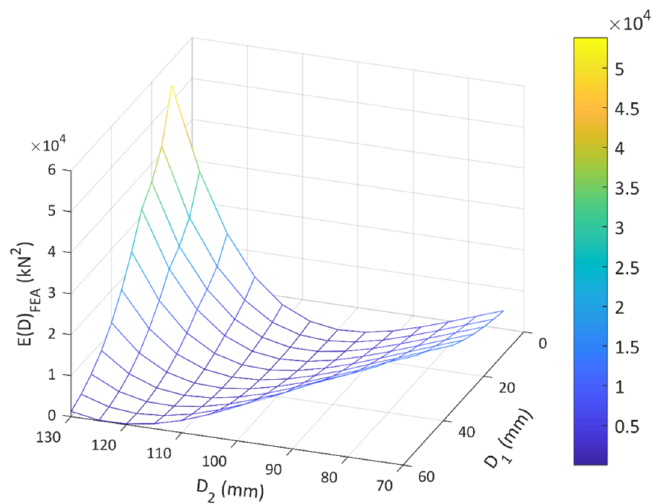
Figure 3. The objective function value in design space by applying a finite element model. Table 1. Calculated cost function value in different design points.